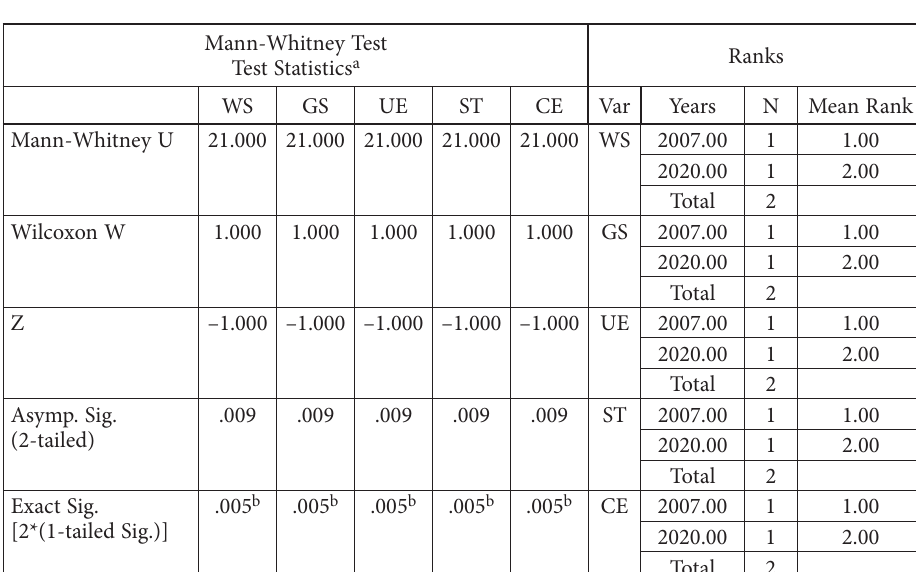
Wald-Wolfowitz Test Test Statistics a,b Number of Runs Exact Number 2 c of Runs